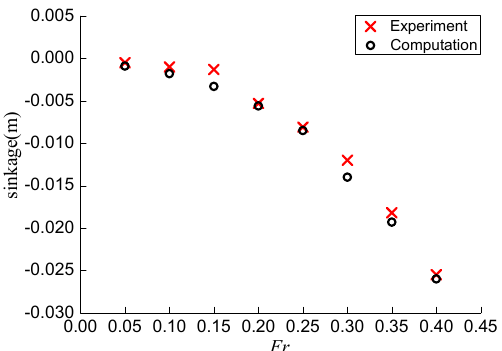
Figure 10. Comparison of sinkage obtained by computation and experiment for intact ship at different forward speeds.